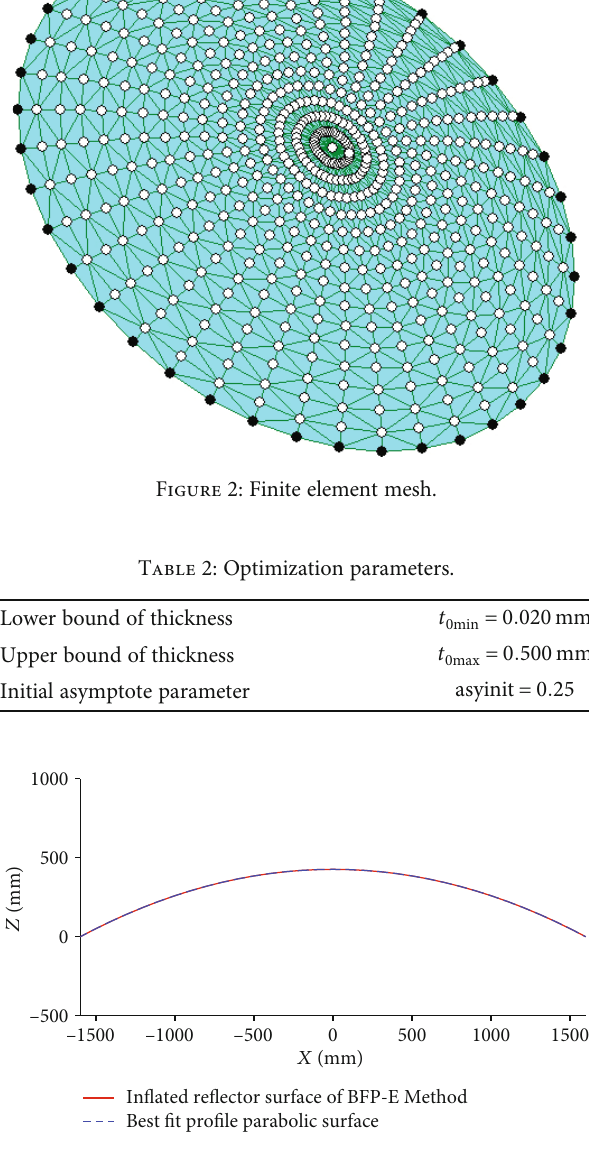
Figure 3: Section pro fi le of in fl ated re fl ector of optimal result by the BFP-E